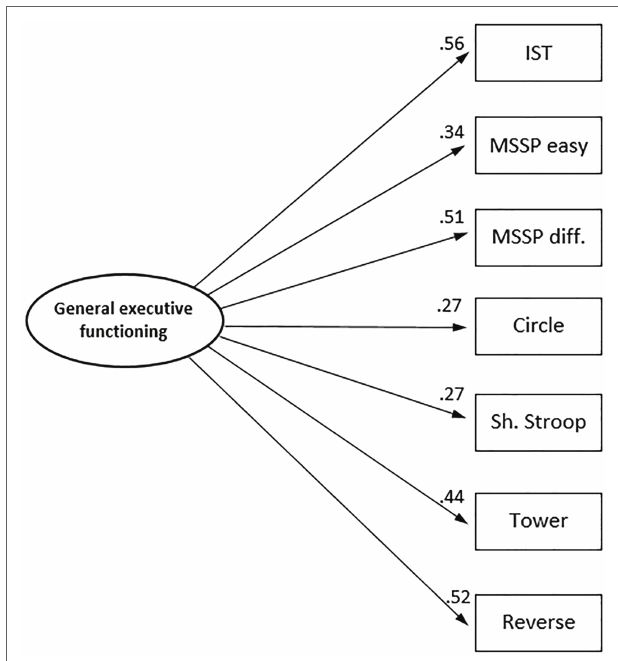
FIGURE 2 | Best-fitting measurement model (one-factor model) for the working memory capacity, inhibition, and shifting measures. IST, imitation sorting task; MSSP easy, memory span spin-the-pots, easy condition; MSSP diff., memory span spin-the-pots, difficult condition; Circle, circle tracing; Sh. Stroop, shape stroop; Tower, tower building; Reverse, reverse